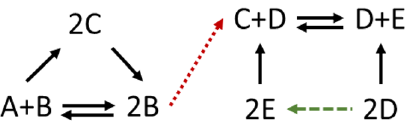
Figure 3. Stoichiometric BCs in a toy network. The conversion diagram depicts a base network with m = 5 species, n = 7 complexes, and r = 6 base reactions, two of which are reversible. The network has four BCs, which will remain balanced even if one adds the dashed reaction (highlighted in green). However, once one adds the dotted reaction (highlighted in red), only two of these complexes remain balanced.